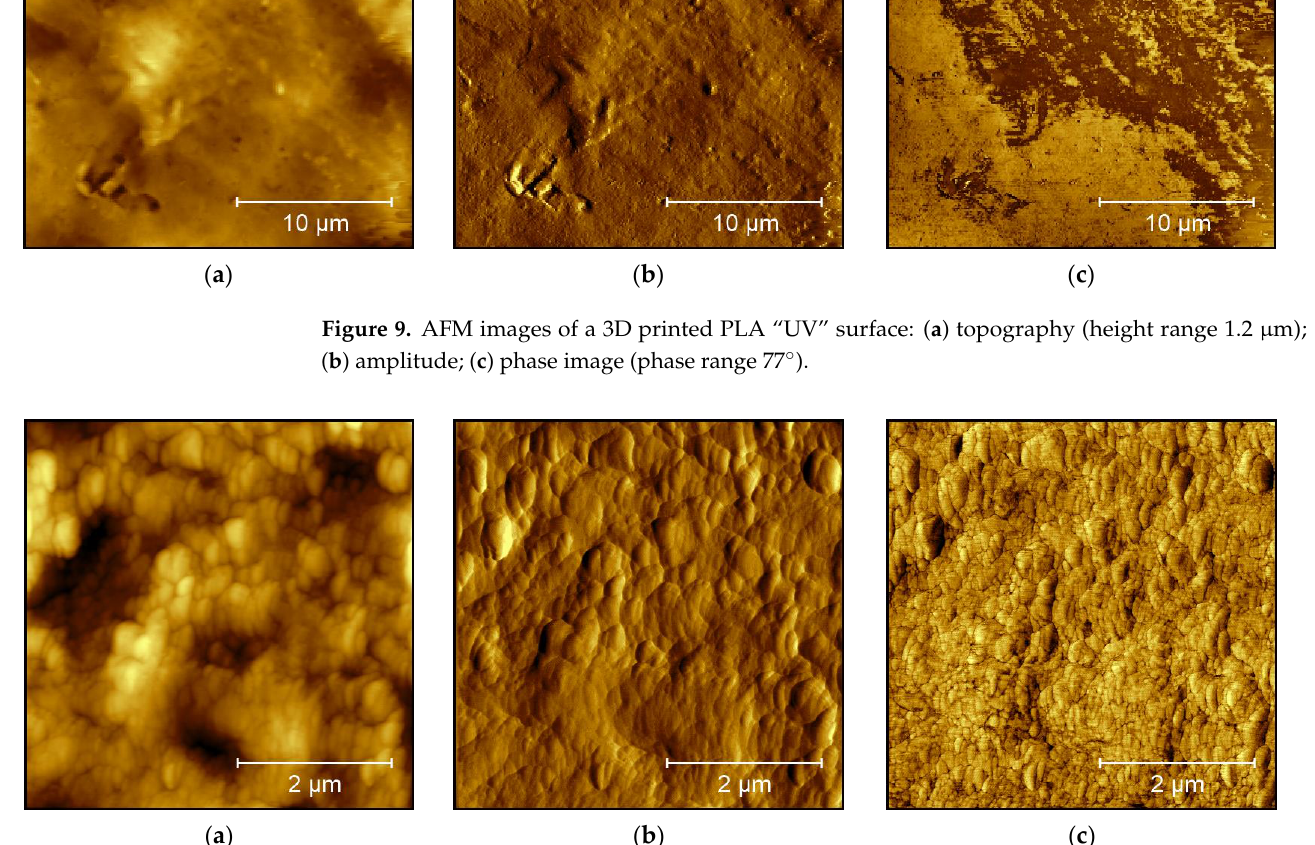
Figure 10. AFM images of a 3D printed PLA “UV” surface, taken at another position: ( a ) topography (height range 265 nm); ( b ) amplitude; ( c ) phase image (phase range 26°).